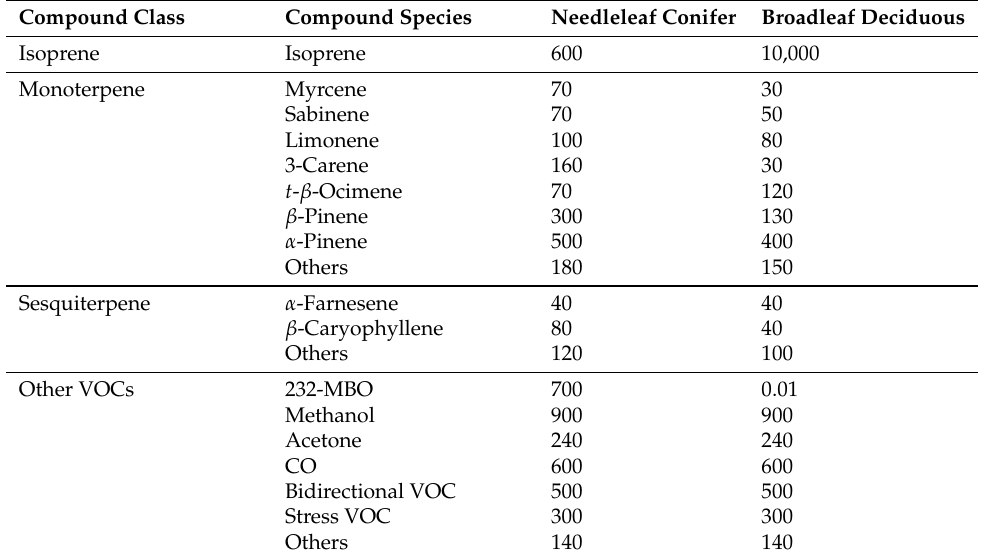
Table 1. Emission rate (µgm − 2 h − 1 ) of each BVOC species under standard conditions for PFTs in the temperate climate regions (adapted from Table 2 in Guenther et al.